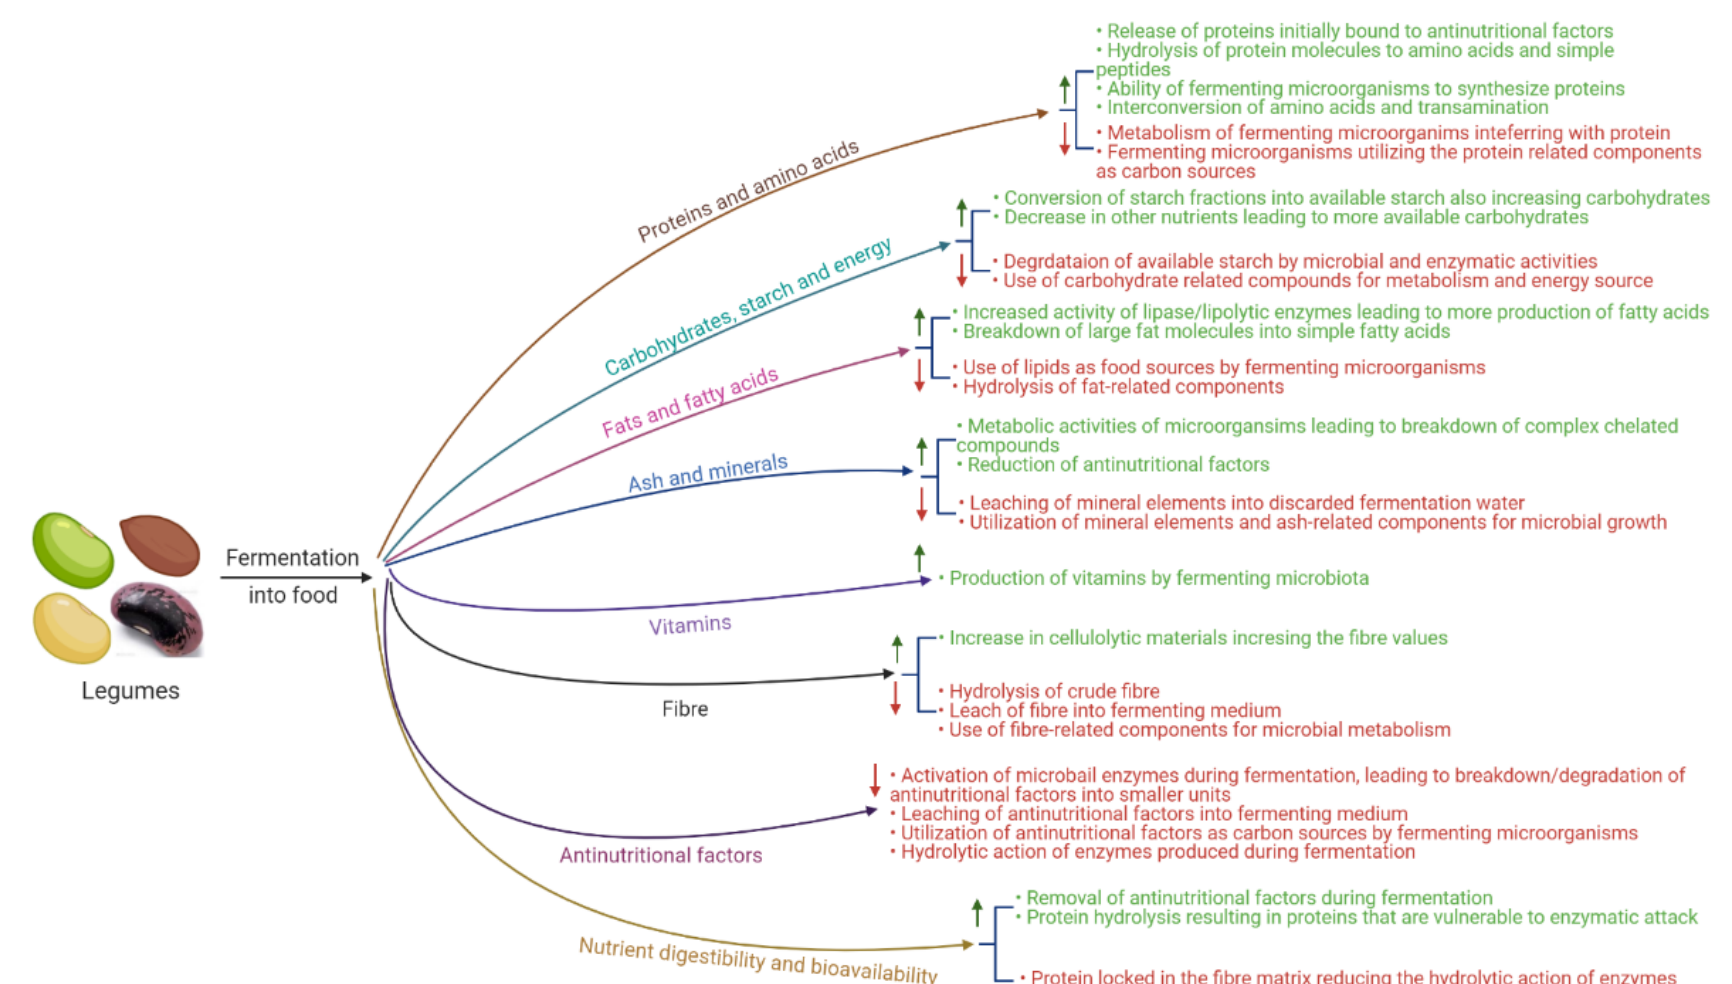
Figure 2. A summarized mechanisms of nutrient modifications in fermented legumes.